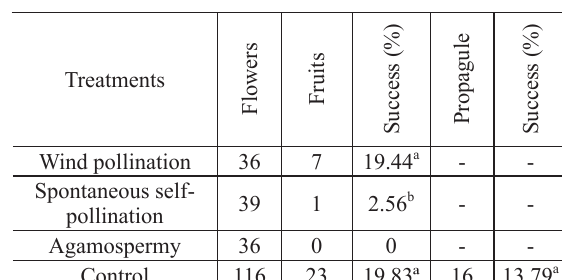
Results of wind pollination and reproductive system treatments of Rhizophora mangle (Rhizophoraceae), in a mangrove area in Goiana, Pernambuco, Brazil. Superscript letters indicate significant statistic differences